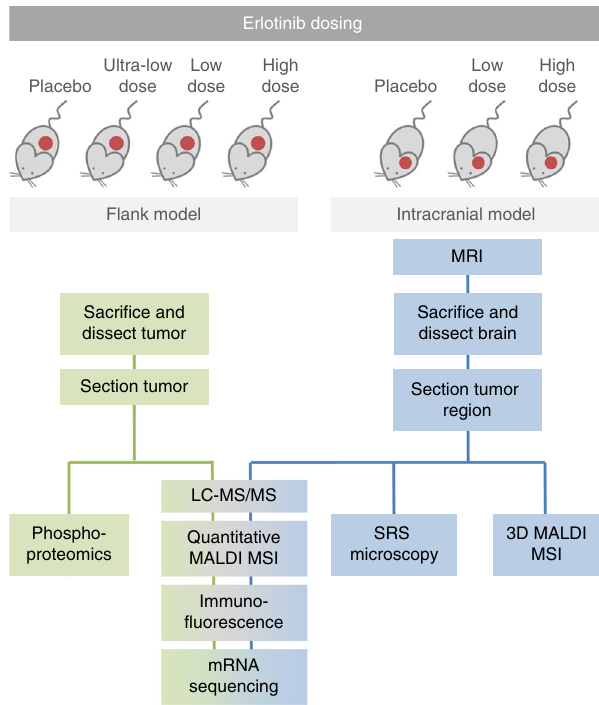
Fig. 1 Schematic of multimodal analysis work fl ow for investigation into drug delivery and response. Two groups of mice were injected with patient- derived GBM12 tumor cells to establish xenografts either in the fl ank or brain. Mice in both groups were treated with either placebo, ultra-low dose (5 mg kg − 1 ), low dose (33 mg kg − 1 ), or high dose (100 mg kg − 1 ) erlotinib. Tissue from mice in each group was analyzed according to the work fl ow shown in the